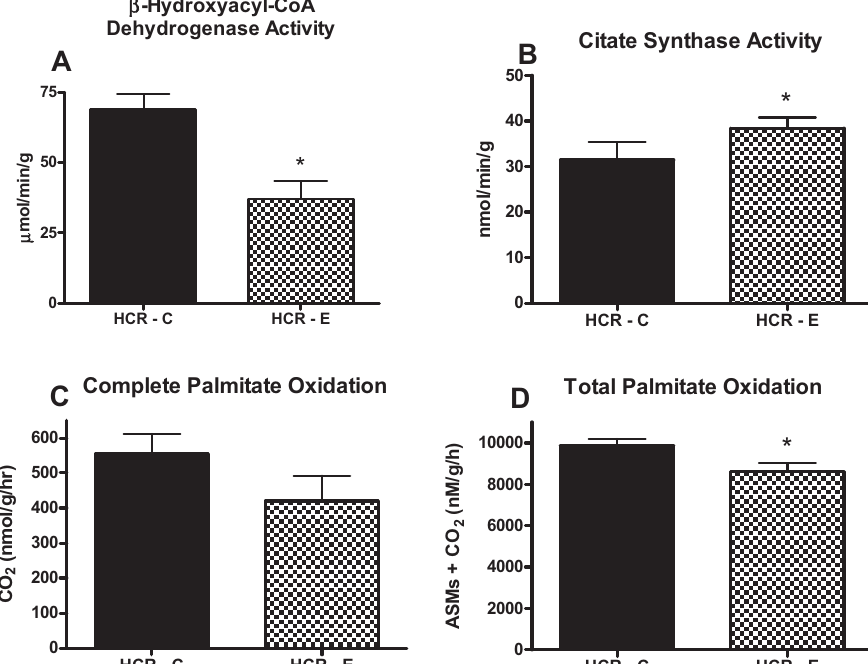
Figure 2. Effects of ethanol consumption on hepatic (cid:2)-HAD activity ( A ); citrate synthase activity ( B ); complete (oxidation to CO 2 ) hepatic palmitate oxidation ( C ); and total palmitate (CO 2 + ASMs) oxidation ( D ). Values (means ± SE) with * are significantly different ( p < 0.05); n = 7–8/group.